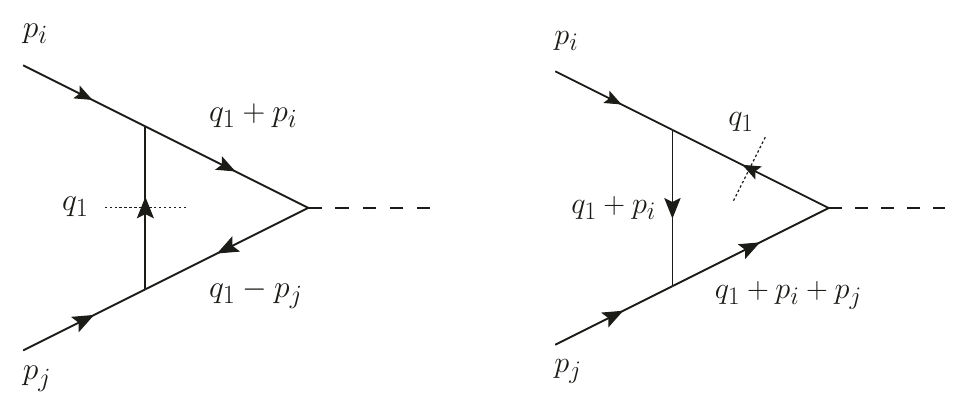
Figure 4. Cut loop contributions giving rise to divergences for the case of radiation from the initial